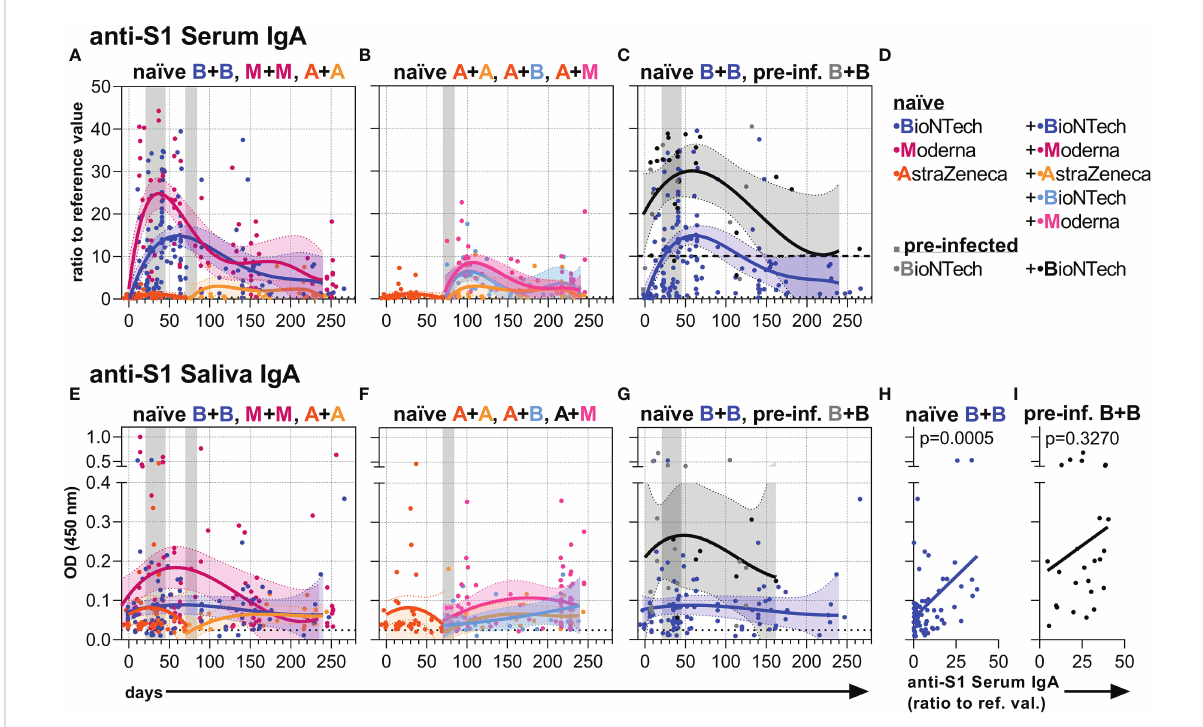
FIGURE 3 Anti-S1 serum and salivary IgA levels. (A-C) Anti-S1 serum IgA levels (ratios to reference value) of the indicated six vaccination groups. (D) Color legend of the six study groups. (E-G) Anti-S1 salivary IgA levels (OD 450 nm values) of the indicated six groups. Gray bars: time windows of the second shot after the fi rst shot with an mRNA (between day 21 and 45) or adenovirus-based (between day 70 and 84) vaccine. Dashed and dotted lines indicate the corresponding anti-S1 IgA average levels of pre-infected individuals without/before vaccination or non-vaccinated healthy (negative) controls, respectively. (H, I) Pearson correlations between anti-S1 serum IgA and salivary IgA levels (y-axis as in (E) ) of all paired samples from once and twice BNT162b2-vaccinated naïve and pre-infected individuals. p -values of the indicated correlations are